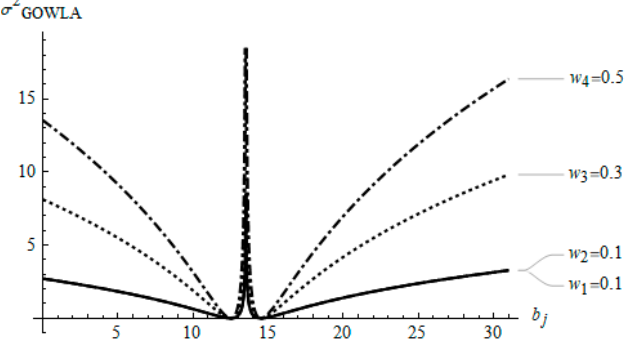
Figure 3. 𝜎 (cid:2870) (cid:2891)(cid:2899)(cid:2907)(cid:2896)(cid:2885) operator behavior with λ = 2 for conditions in Example 1.